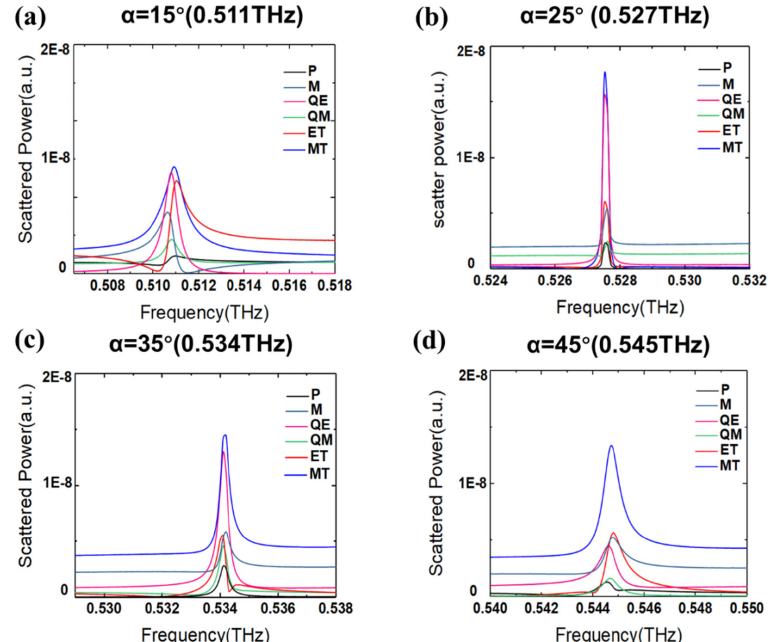
Figure 6. Calculated scattering powers of multipoles decomposition for the studied metasurface, where P, M, QE, QM, ET, and MT are the electric dipole, magnetic dipole, electric quadrupole, magnetic quadrupole, electric toroidal dipole, and magnetic toroidal dipole, respectively. ( a ) Incident angle of 15° with a resonant frequency of 0.511 THz; ( b ) Incident angle of 25° with a resonant fre ‐ quency of 0.527 THz; ( c ) Incident angle of 35° with a resonant frequency of 0.534 THz; ( d ) Incident angle of 45° with the resonant frequency of 0.545 THz.